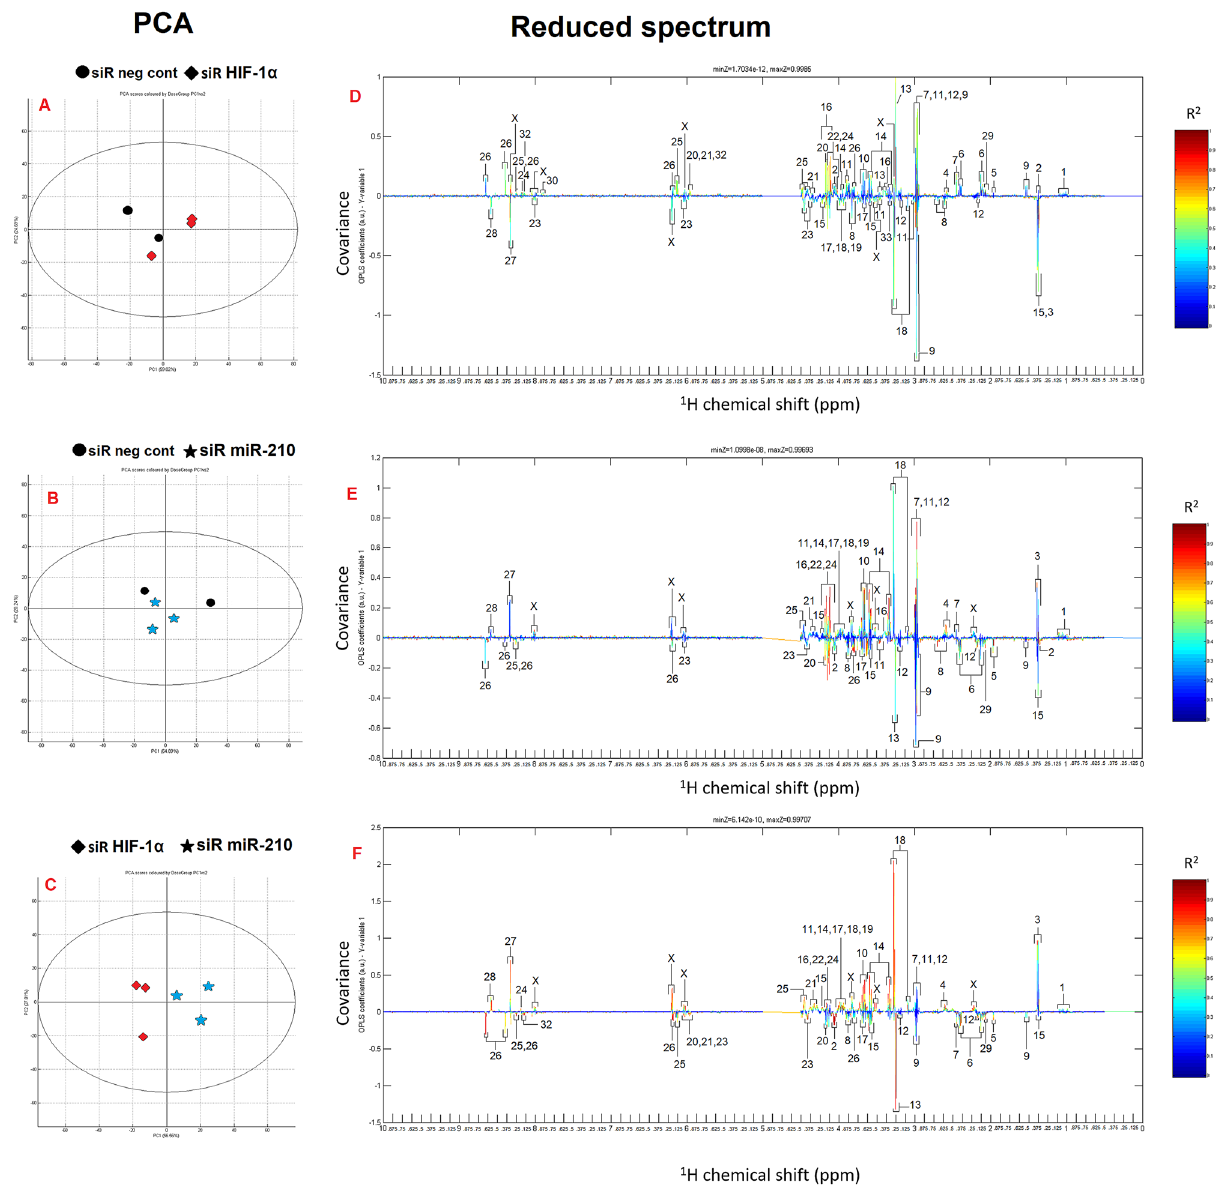
Figure 6. PCA model between the groups ( A ) siR neg cont and siR HIF-1α, ( B ) siR neg cont and siR miR-210, ( C ) siR HIF-1α and siR miR-210; 1 H NMR spectra colour map of metabolite significance variations between the groups, ( D ) siR neg cont and siR HIF-1α, ( E ) siR neg cont and siR miR-210, ( F ) siR HIF-1α and siR miR- 210. Peak in positive direction indicates the increased level of metabolite, peak in negative direction indicates decreased level of metabolite ( X—undefined metabolite). Analysed by Bruker Topspin 3.1 and MestReNova 10.0 software (Mestrelab Research, Santiago de Compostela,